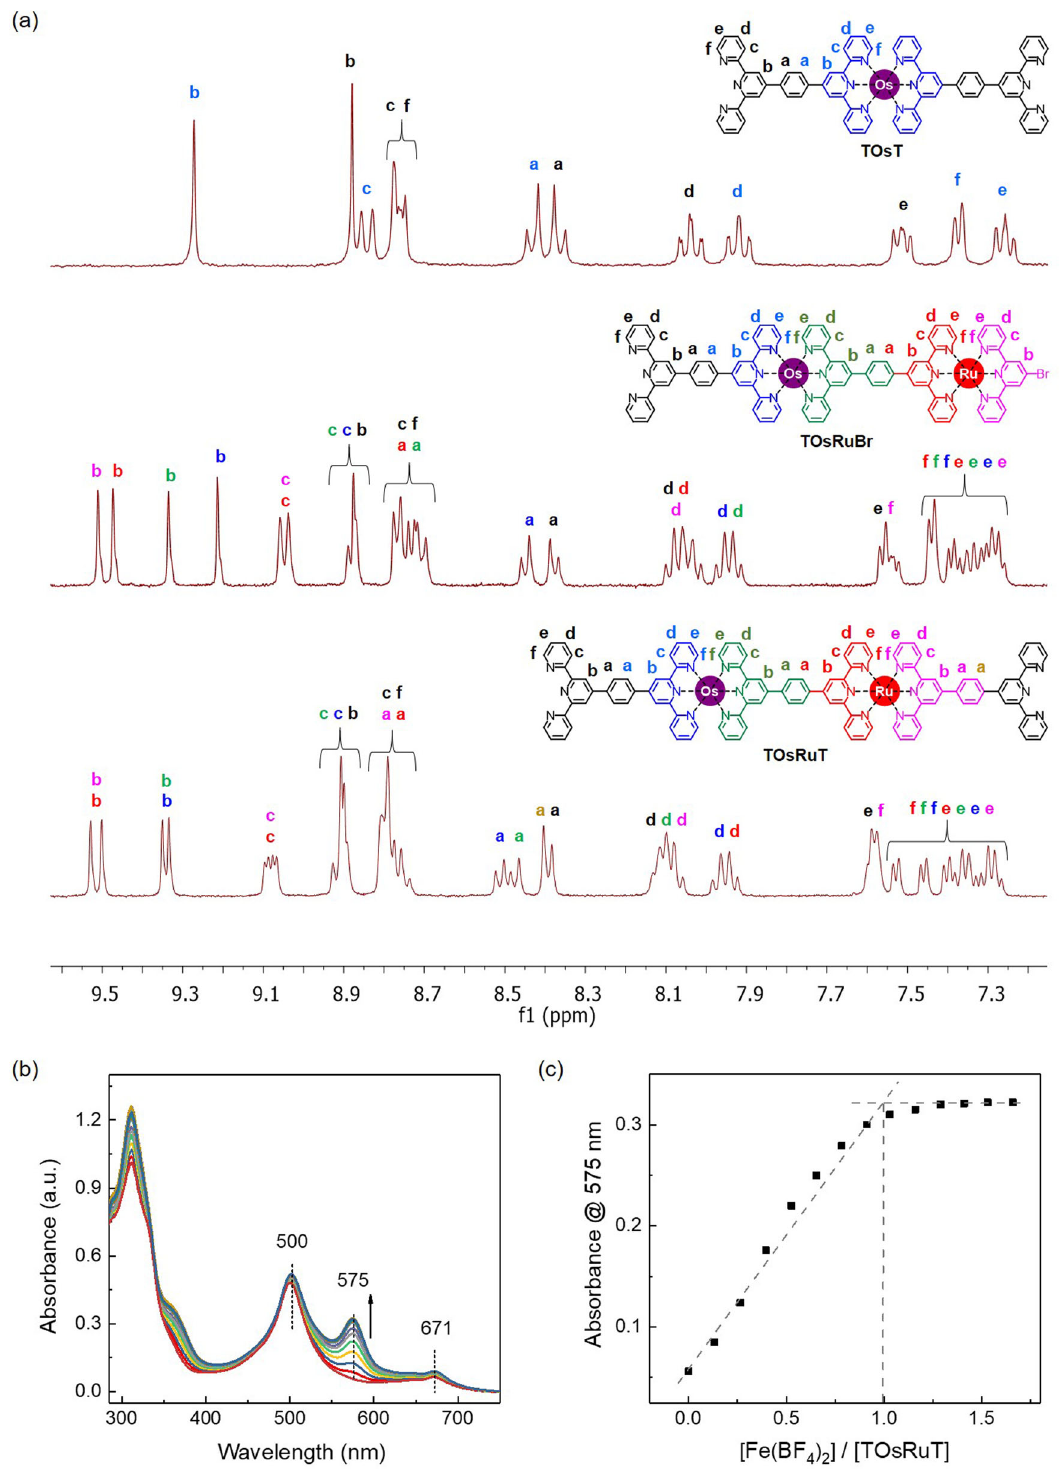
Fig. 2 Characterization of the intermediate compounds by NMR and titration of TOsRuT with Fe(II). a Comparison of the 1 H NMR spectra of TOsT, TOsRuBr, and TOsRuT with peak assignments in CD 2 Cl 2 /CD 3 OD (1:1, v/v). Assignment of protons: b = 3 ′ ,5 ′ ; c = 3,3 ″ ; d = 4,4 ″ ; e = 5,5 ″ ; f = 6,6 ″ . b Change in UV – vis absorption upon the stepwise addition of Fe(BF 4 ) 2 in CH 3 OH to TOsRuT (5 × 10 − 6 M in CH 2 Cl 2 /CH 3 OH; 1:1, v/v). c Plot of absorbance of TOsRuT at 575 nm as a function of the [Fe(BF 4 ) 2 ]/[TOsRuT]